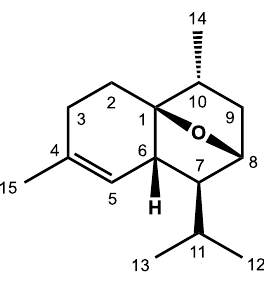
Figure 1. Structure of compound 38 .